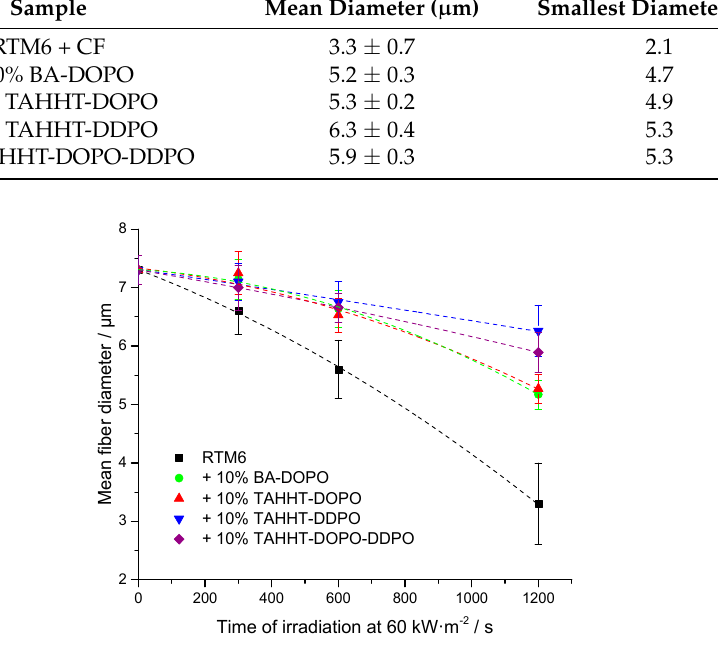
Figure 9. Mean fiber diameter in dependence on irradiation time at 60 kW · m − 2 and flame retarded matrix composition.